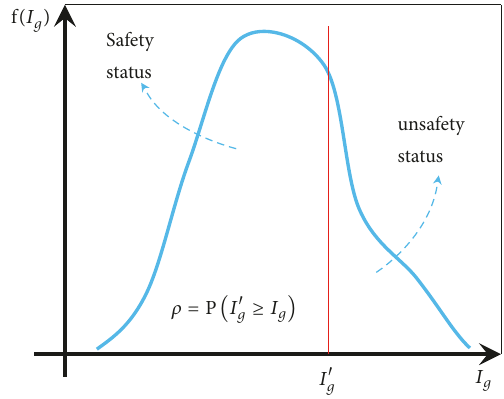
Figure 2: The safety and unsafety status of a signalized